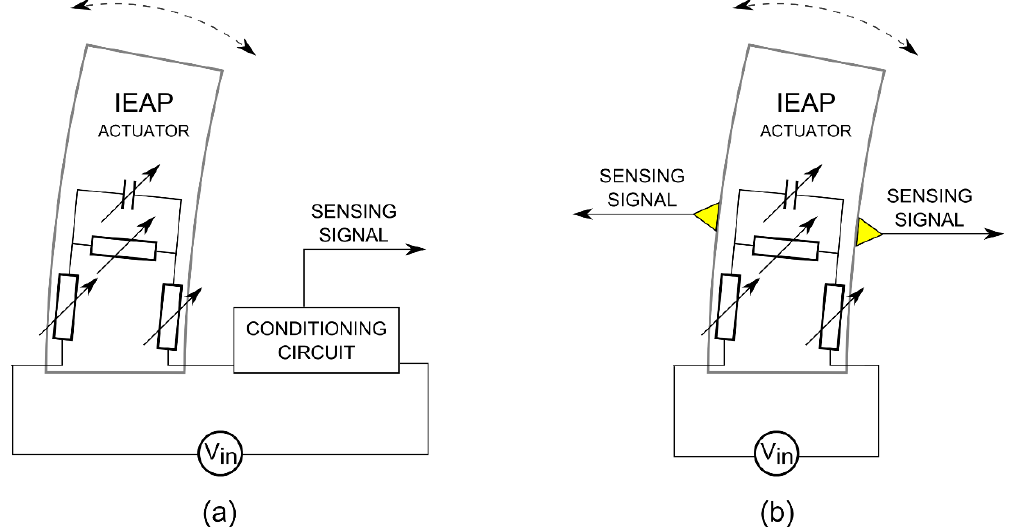
Figure 3. Self-sensing IEAP systems based on deformation-dependent internal